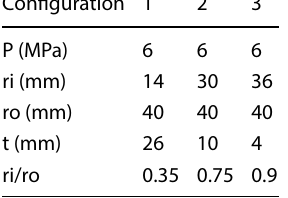
Table 5 Pressure vessel case